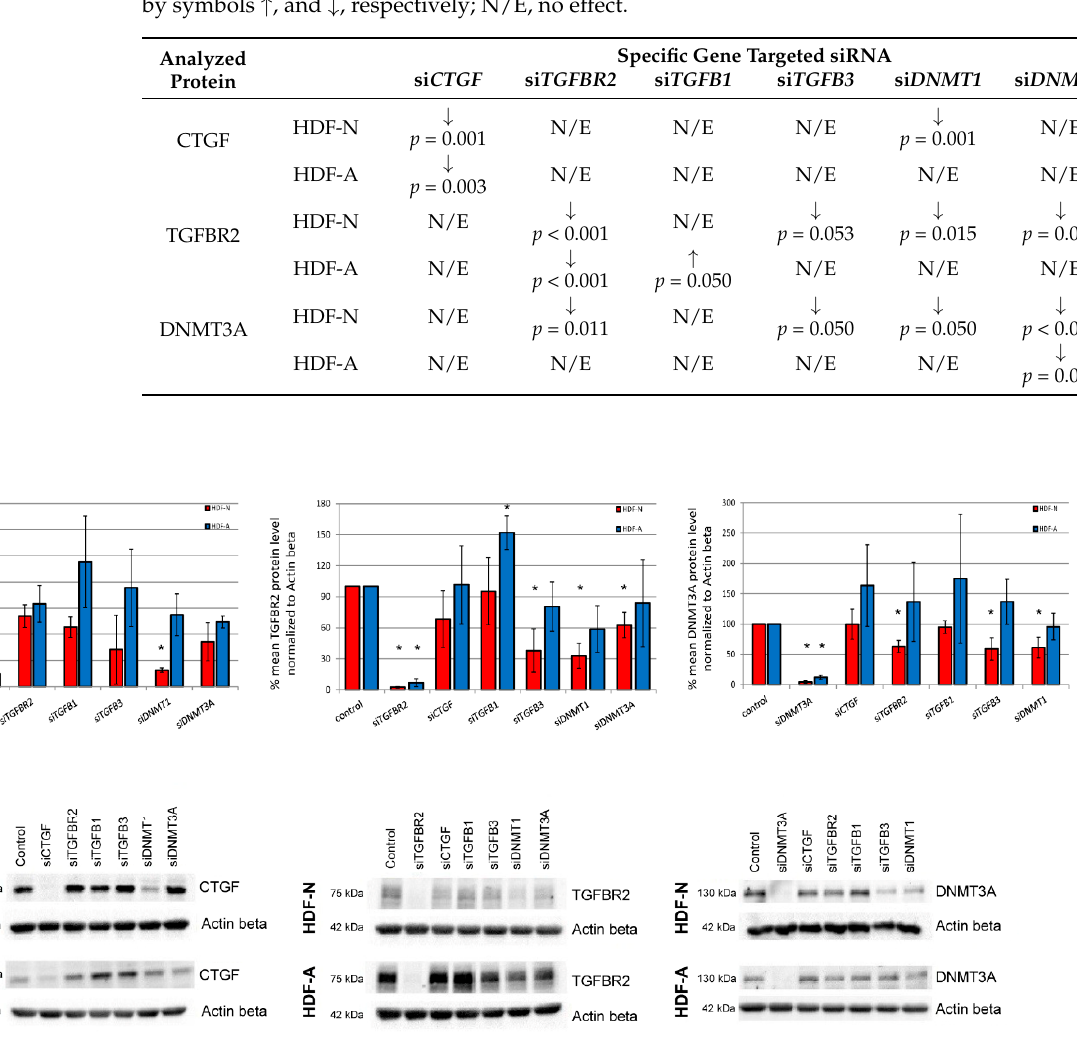
Figure 3. Western blot results ( A ) Quantified levels of the CTGF, TGFBR2 and DNMT3A proteins after siRNA-mediated silencing of CTGF , TGFBR2 , TGFB1 , TGFB3 , DNMT1 , and DNMT3A . The protein band densities were assessed in ImageLab software and % mean protein level was calculated in comparison to a control protein level. All protein levels were normalized to Actin β . The protein level in cells treated with control siRNA was considered as a control (100%). Error bars represent standard error of the mean, * p -value < 0.05. Data are representative of at least three independent experiments. ( B ) The immunoblots of CTGF, TGFBR2 and DNMT3A protein levels in neonatal (HDF-N) and adult (HDF-A) human dermal fibroblast cell lines in response to an in vitro treatment with CTGF siRNA, TGFBR2 siRNA, TGFB1 siRNA, TGFB3